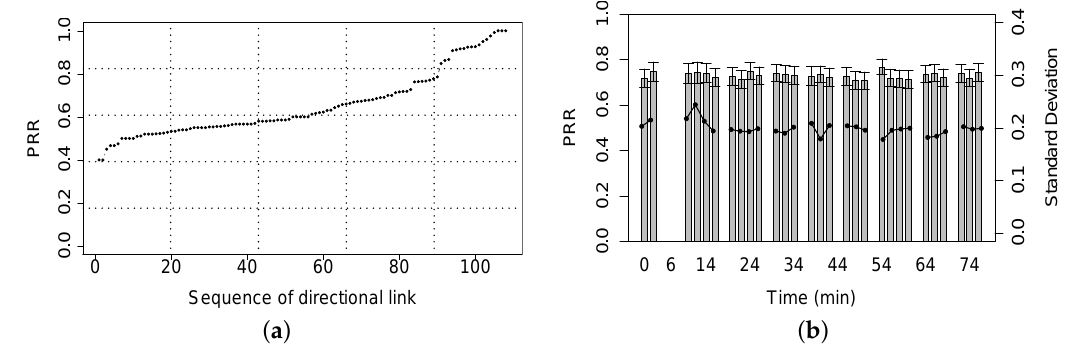
Figure 15. PRR performance of directional links. ( a ) Over each valid directional link; ( b ) Over all valid direction links against